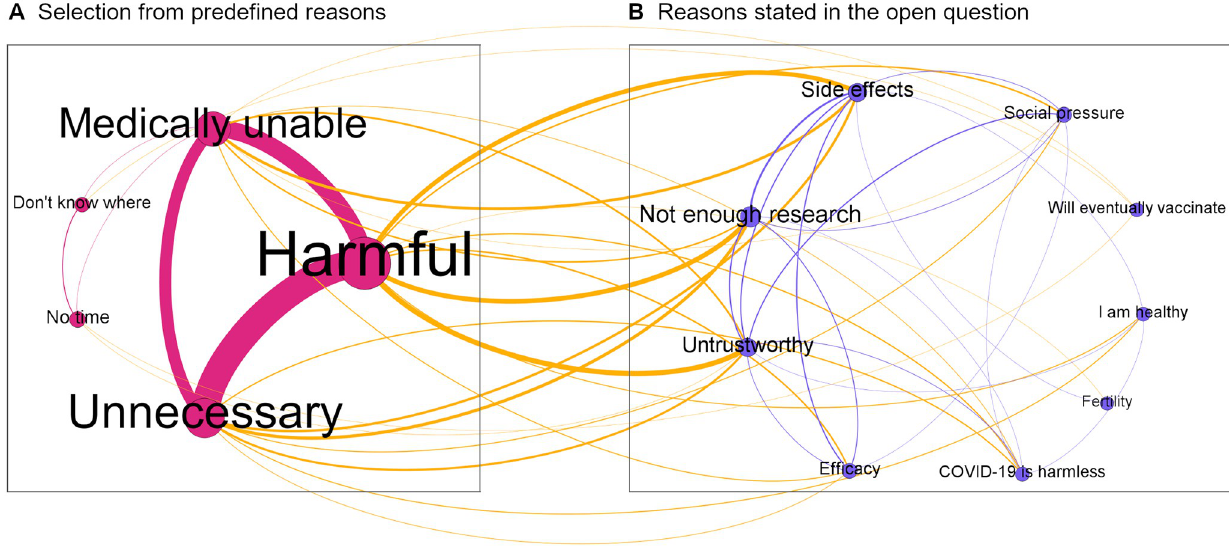
Fig 6. Reasons stated for vaccination inaction. Participants were asked about the reasons why they did not vaccinate. We categorized the reasons listed and highlighted which reasons were mentioned together. Panel A shows the relationship between pre-defined reasons participants could choose from in blue. Panel B shows the relationship of reasons that participants additionally mentioned in an open text box in orange. Connections between pre-defined and self-stated reasons are illustrated in green. The network was illustrated with Gephi